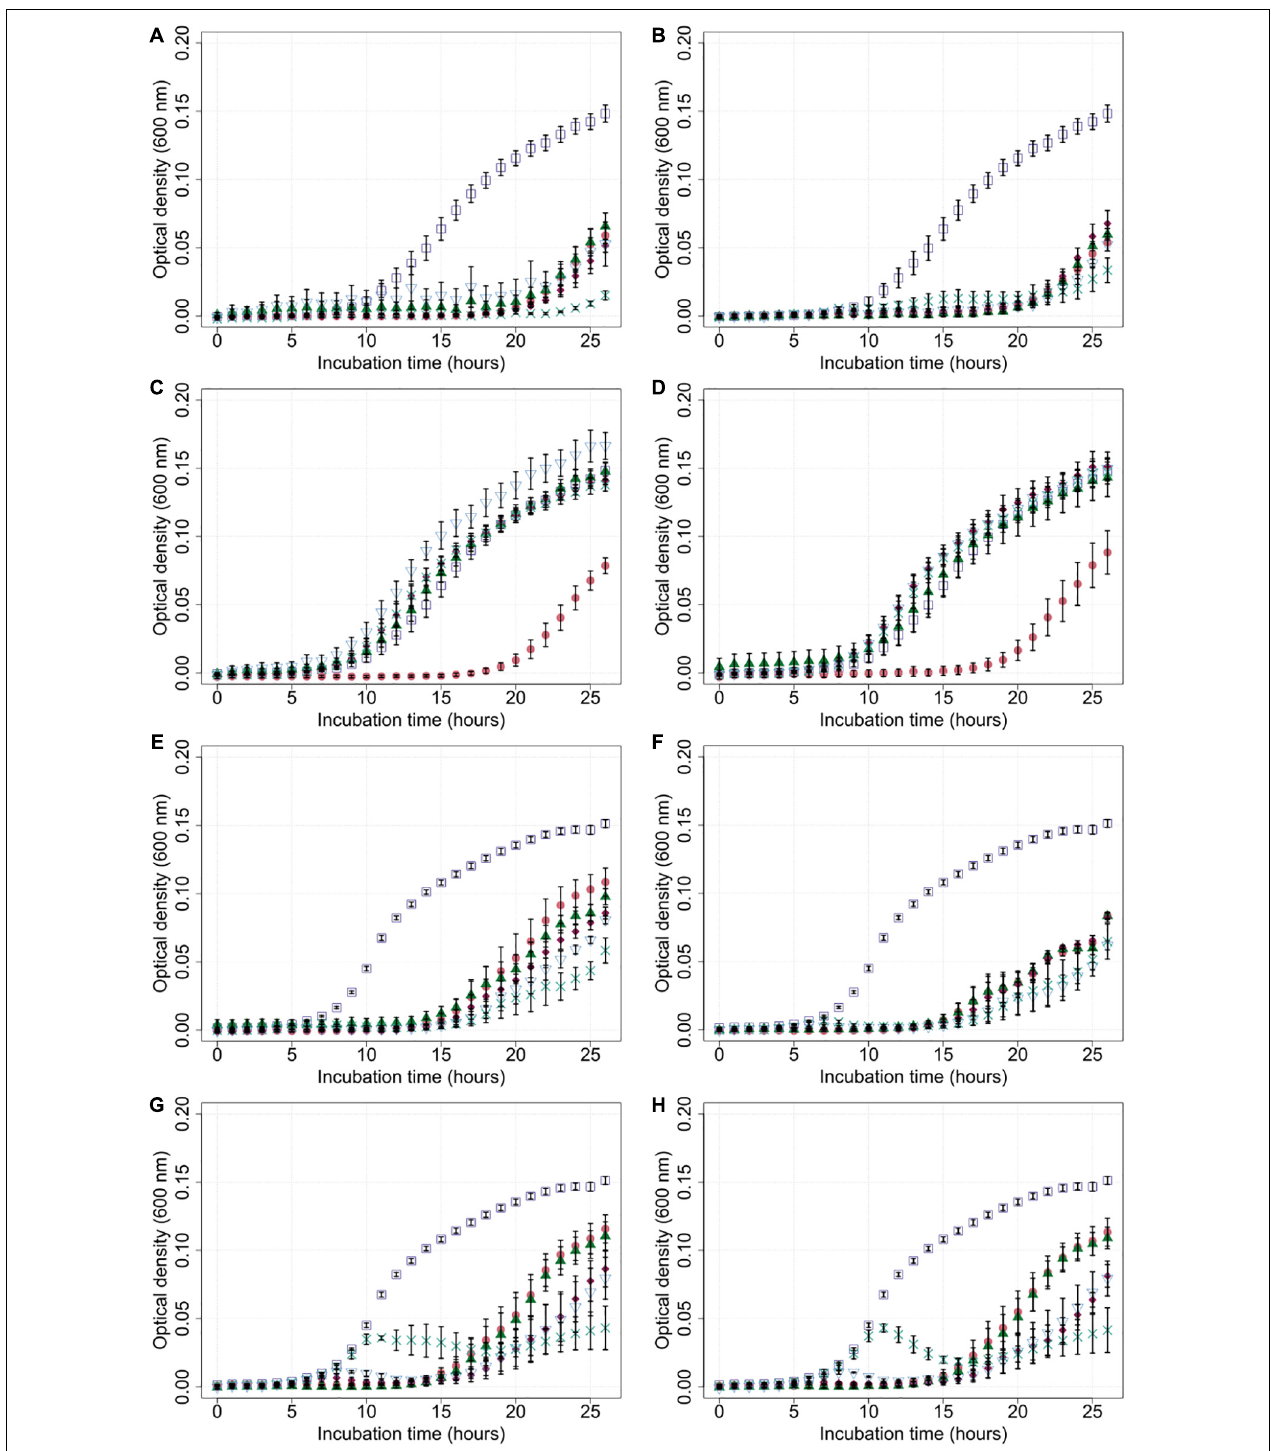
FIGURE 3 | Growth of Campylobacter field isolates Cj18 and LH86 in presence of different phages. The growth of C. jejuni field strains Cj18 (A–D) and LH86 (E–H) was inhibited by all phages. Different multiplicities of infection (MOI input ) used, resulted in different reduction efficiencies. Experiments were performed in a Tecan Spark Microplate Reader under microaerobic conditions at 42 ◦ C. Optical density was measured every hour at 600 nm for 26 h. (A,E) vB_CjM-LmqsCP1-4, (B,F) vB_CjM-LmqsCP1-5, (C,G) vB_CjM-LmqsCP74-2c1 and (D,H) vB_CjM-LmqsCP132-3c were added to achieve different MOI input : no phages added, MOI input 10, MOI input 1, MOI input 0.1, MOI input 0.01, and x MOI input 0.001. Curves represent mean OD 600 values of triplicate experiments with two replications per plate. Error bars indicate standard error of the